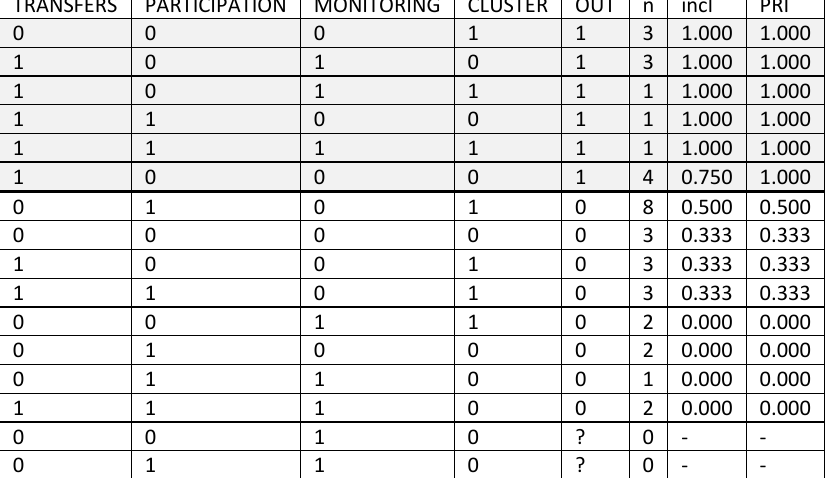
Table A2.4 Truth table for analysis of sufficiency for successful drought adaptation